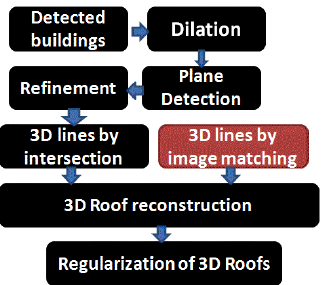
Fig. 3. Workflow of the reconstruction.